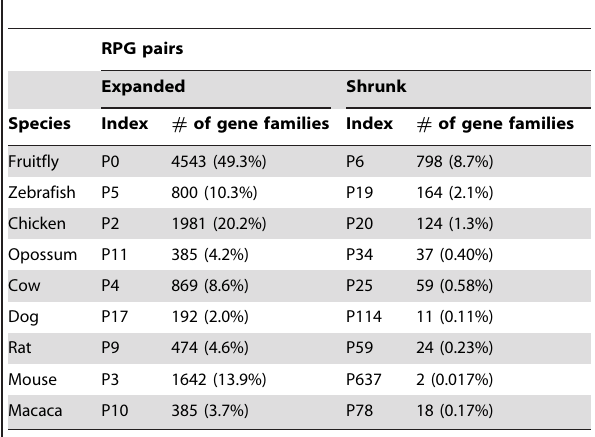
Table 3. Species-specific conjugated RPG pairs.